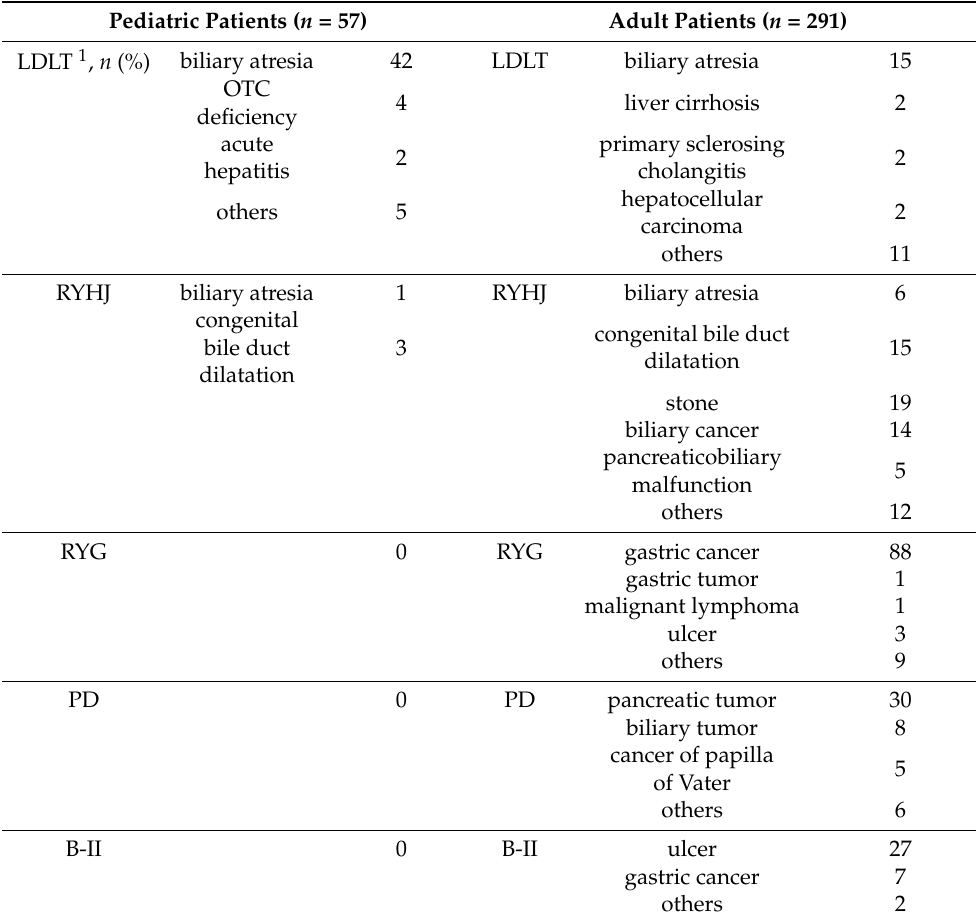
Table 2. Primary indication for